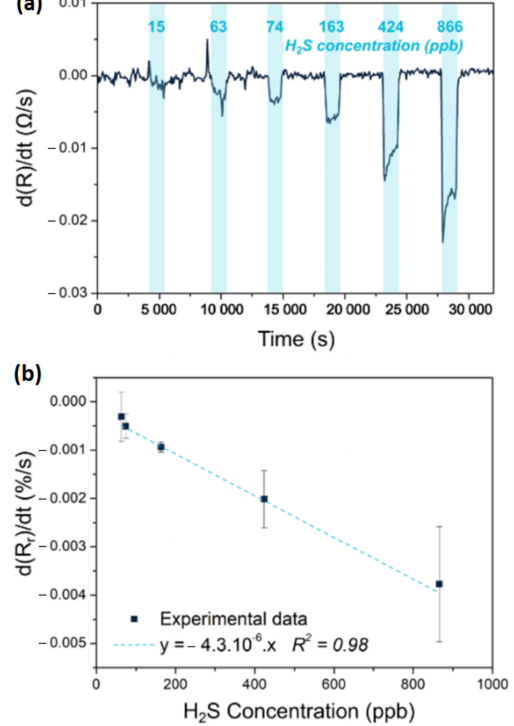
Figure 7. Response to hydrogen sulfide of a chemiresistor based on a Polyaniline-SnCl2-PEDOT:PSS blend. ( a ) shows the derivative of the response evolution and ( b ) a corresponding calibration curve expressed as the variation of the relative response as a function of the concentration of hydrogen sulfide. Adapted from